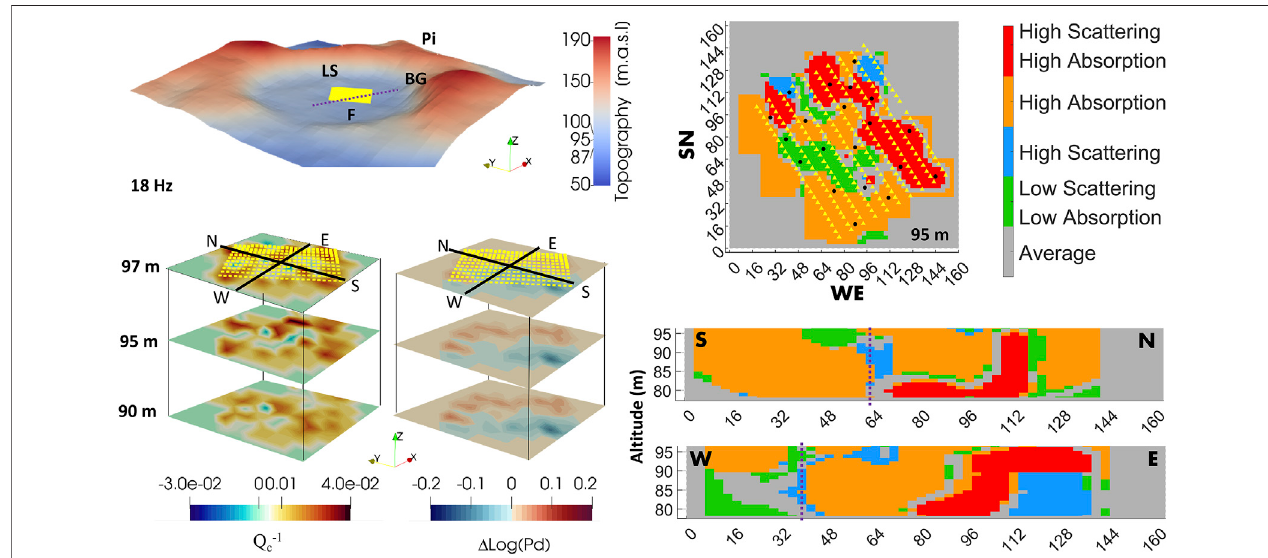
FIGURE 8 | Left: The topography image indicates the location of the survey area (yellow rectangle), the main fumaroles, and the interpreted NW-SE fault from our results (dashed purple line). Absorption and scattering sections across the fi rst 10 m are stacked below the topography, showing the trace of two vertical sections (SN andWE).Right:Parametermapsobtainedat18 Hzbyseparatingthemappedvaluesintheirparameterspace(thelocationofthestationsandsourcesisindicatedbythe yellow triangles and the black circles, respectively).